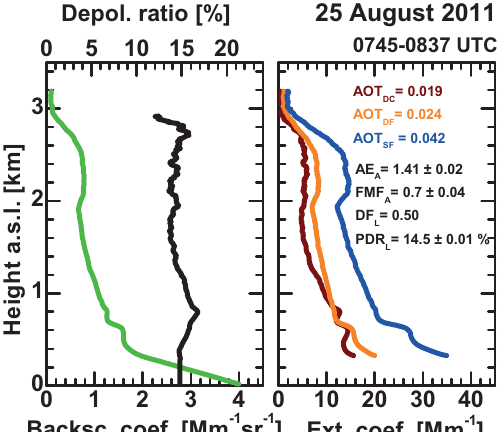
Figure 10. 532nm particle backscatter coefficient (green pro- file, left panel), particle linear depolarization ratio (black profile, left panel), and lidar-derived particle extinction coefficients (right panel) for spherical fine-mode particles (blue profile, index SF), fine-mode dust particles (orange profile, index DF), and coarse- mode dust particles (dark red profile, index DC). The extinction co- efficient profiles are obtained by using the method of Mamouri and Ansmann (2014). The respective free tropospheric AOTs (above 300–400m height), the AERONET-derived Ångström exponent AE A and fine-mode fraction FMF A (for total tropospheric column), and the lidar-derived dust fraction DF L (with respect to the free tropospheric 532nm AOT) are given as numbers together with the layer-mean depolarization ratio PDR L and standard deviations. The measurement was taken on 25 August 2011.